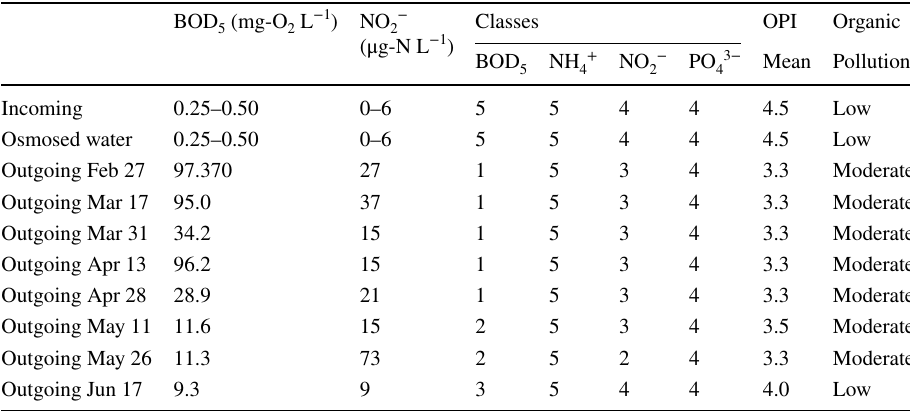
Table 4 Organic pollution of the waters in the pharmaceutical plant from February 27 to June 17,